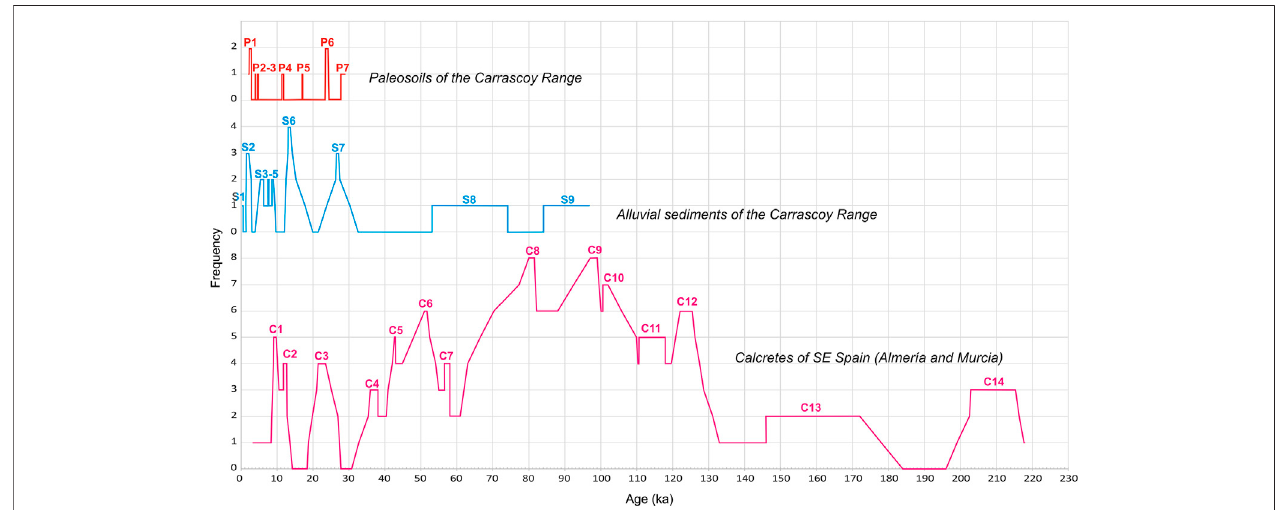
FIGURE 7 | Frequency distribution of the geochronology of the SE Spain calcretes obtained by the U-Series method and published (pink line). The period of maximumfrequencyareinterpreted ascalcreteformationperiods (C1-C14). Frequency distribution oftheagesofthesediments(blueline)sampledalongtheCarrascoy Range and analyzed by OSL and 14C-AMS. Sedimentation periods (S1-S9). Frequency distribution of the ages of the paleosoils (red line) sampled along the Carrascoy Range and analyzed by 14C-AMS. Periods of formation of paleosoils